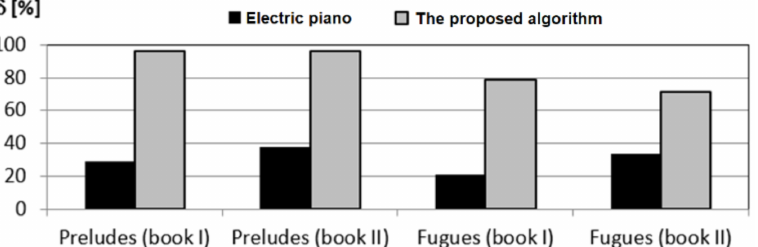
Figure 10. Comparison of the efficacies δ , defined as the percentage of the music pieces for